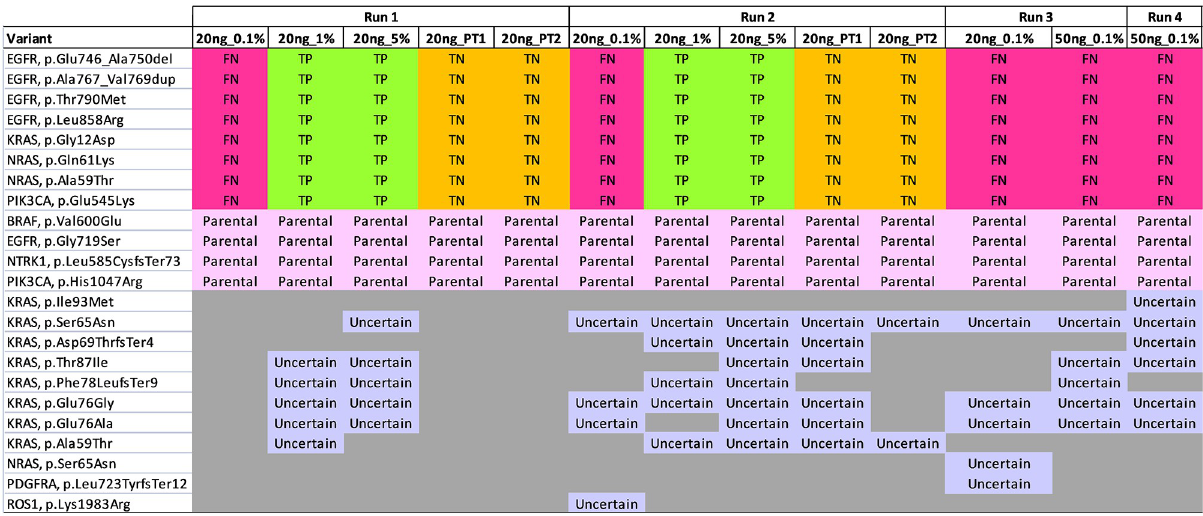
Fig 1. Analytical validation of the Horizon Multiplex I ctDNA reference standards. Variants are listed vertically and samples are shown horizontally. True positive (TP), false negative (FN), true negative (TN), and variants of uncertain significance are shown in green, red, orange and purple respectively. Parental variants are shown in pink (allelic frequencies range 19%–32%). Run 1 and 2 included 20 ng Horizon 5%, 1%, 0.1% and duplicates of parental ctDNA. Run 3 included 20 ng and 50 ng Horizon 0.1% ctDNA. Run 4 included 50 ng Horizon 0.1% ctDNA. Our results demonstrated that the detection limit of the assay was at 1% allelic frequencies, and achieved 100% analytical sensitivity and 100% analytical specificity.